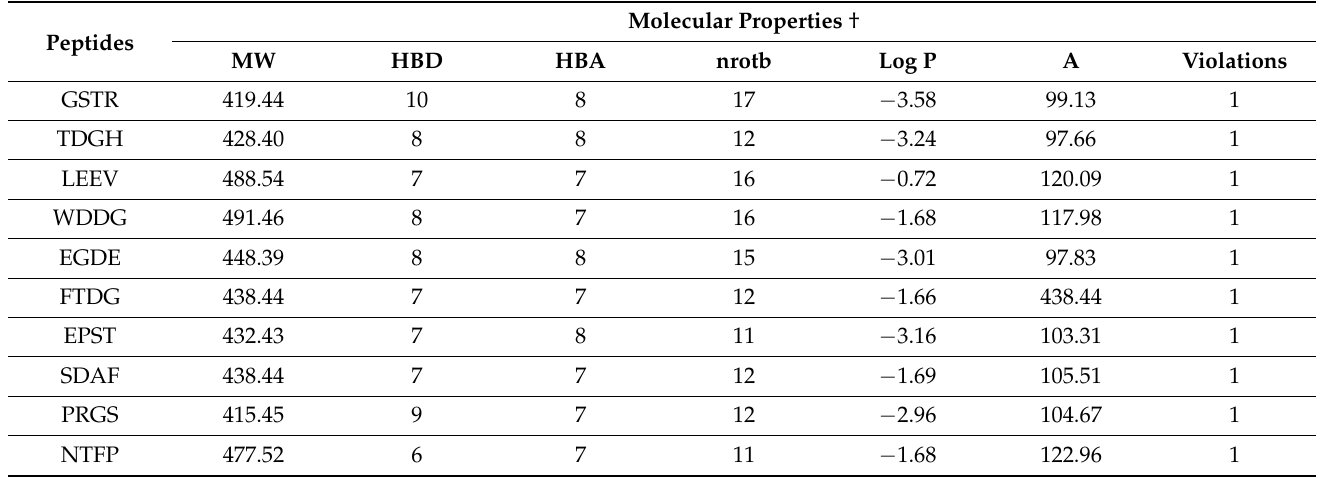
Table 2. Drug-like properties of selected antimicrobial peptides.